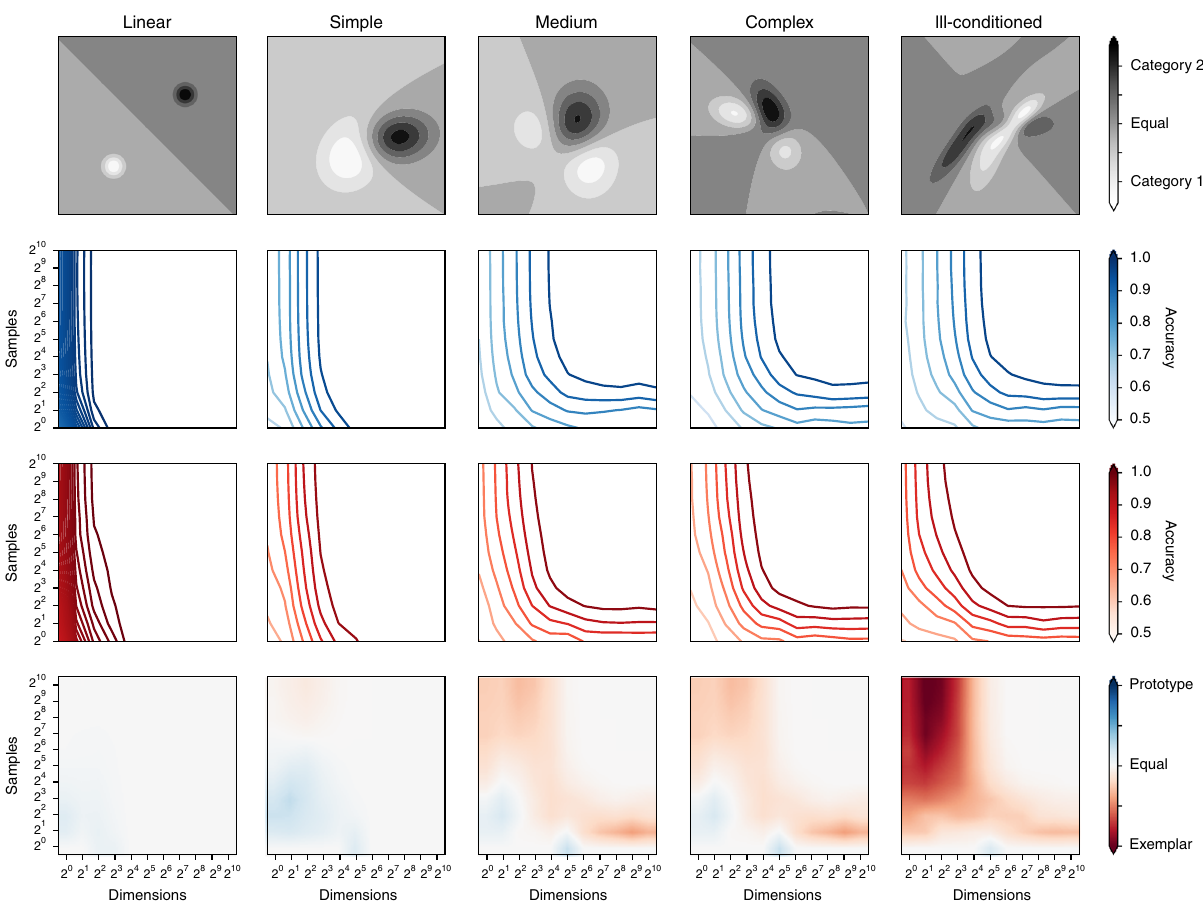
Fig. 7 Performance of categorization models depends on dimensionality of stimuli. Categories of increasing complexity were created (columns, left to right), and prototype and exemplar accuracy compared on stimuli sampled from them. Top row: representative category structures. Middle rows: prototype (blue) and exemplar (red) model accuracy, as the number of dimensions (horizontal axes) and training samples (vertical axes) varies. Bottom row: comparison of middle rows (prototype accuracy — exemplar). Each point represents the averaged results from 300 different distributions, with bilinear smoothing between points. In different regimes, the relative performance of prototype and exemplar models varies signi fi cantly, in particular between the regimes covered in laboratory studies (top left) and those necessary to cover more naturalistic categorization studies (top right). Source data are provided as a Source Data fi